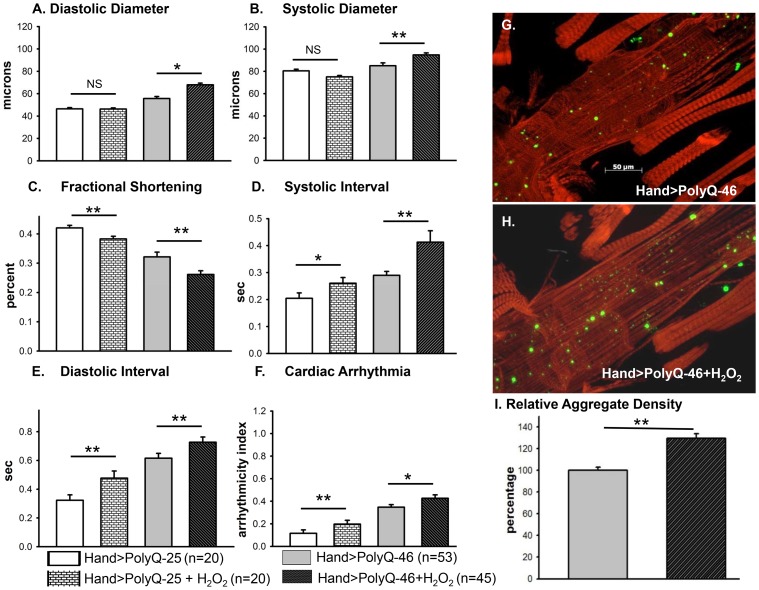
Cardiac function of hearts expressing control PolyQ-25 and mutant PolyQ-46 affected differently by oxidant.(A & B) The already large systolic and diastolic heart diameters were further increased in the presence of the oxidant H2O2 in the hearts expressing PolyQ-46. (C) Cardiac contractility (% FS) was further decreased in the presence of the oxidant in hearts expressing PolyQ-46. (D & E) The already prolonged systolic and diastolic intervals in hearts expressing PolyQ-46 were further increased by feeding flies the oxidant H2O2. (F) The incidence of cardiac arrhythmias was further increased in the presence of oxidant compared to age-matched PolyQ-46 expressing hearts without oxidant (A–F). Hearts expressing PolyQ-25 in the presence of oxidant showed cardiac defects without cardiac dilations (A–F). Data are shown as means ± SE. (G) Actin staining and GFP aggregates in heart expressing PolyQ-46 without oxidant. (H) PolyQ-46 expressing heart from fly fed oxidant showed more myofibrillar defects and contained more GFP-positive aggregates compared to controls. (I) Number of aggregates/unit area is expressed as percentage relative to control. Flies fed oxidant had 30% more aggregates than did hearts from age-matched PolyQ-46 without oxidant. For all data statistical significance was determined using one-way ANOVA and Dennett's post-hoc test. Significant differences were assumed for p<0.05. (* = p<0.05, ** = p<0.01, *** = p<0.001).